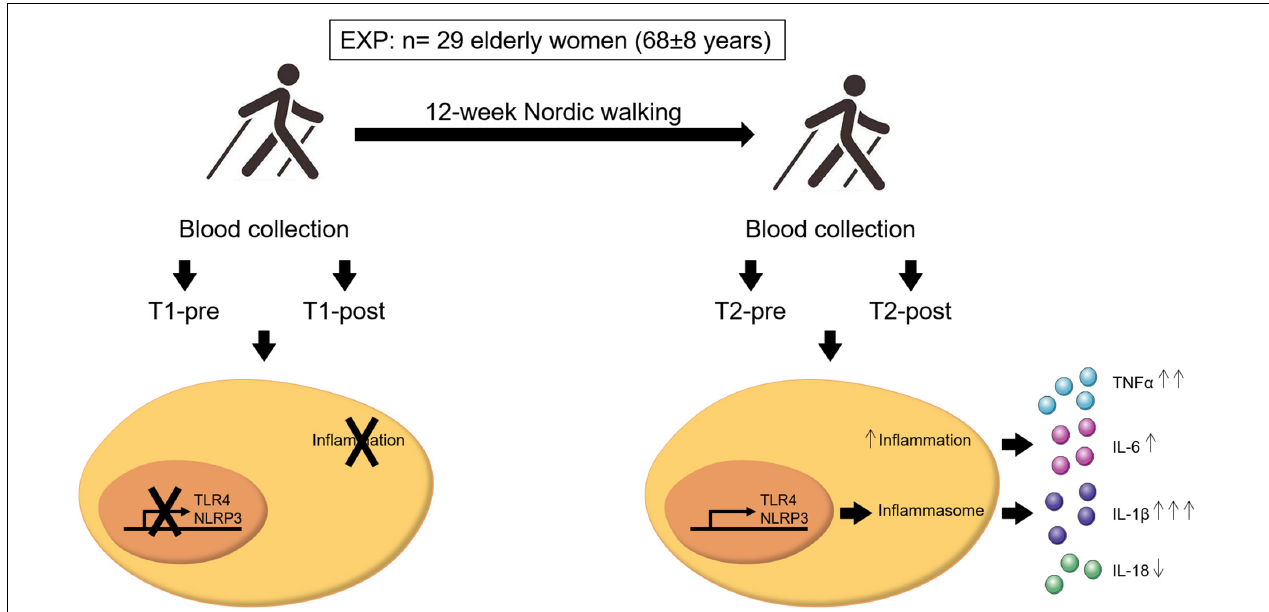
FIGURE 4 | Schematic representation of the important findings of this study. A population of 29 elderly women (age 68 ± 8 years old) completed 12 weeks of Nordic walking moderate-intensity aerobic training program (EXP). Blood samples were taken before and after the first (T1-pre and T1-post, respectively) and last (T2-pre and T2-post, respectively) exercise unit, and inflammasome- and inflammation-related markers were assessed. Aerobic training mildly affected the inflammasome-related inflammatory response. Participants acquired an acute inflammatory response to exercise, that was absent at baseline, that resulted in the activation of NLRP3 and TLR4 gene expression and the consequent release in the blood stream of the inflammasome- and inflammation-related cytokines IL-1 β , IL-6, TNF α , and IL-18. In particular, a single bout of exercise at the end of the training induced a significant upregulation of IL-1 β ( ↑↑↑ ) and TNF α ( ↑↑ ), a non-significant increase of IL-6 ( ↑ ), and a non-significant down-modulation of IL-18 ( ↓ ). The arrows next to the cytokines refer to the entity of the effect of the upregulation or downregulation of these